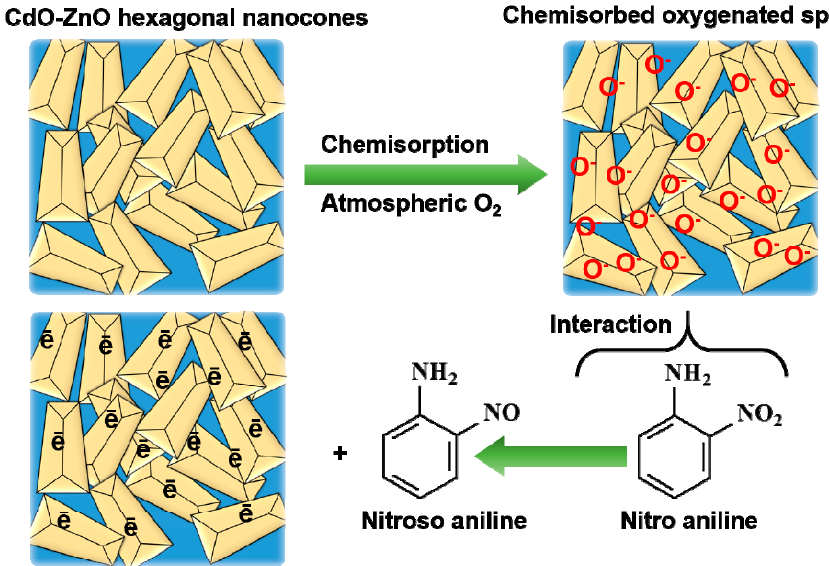
Figure 5. A sensing mechanism for nitroaniline sensing using modified GCE with CdO-ZnO hexagonal nanocones. Adapted figure from [70] with permission from copyright (2017), Elsevier.